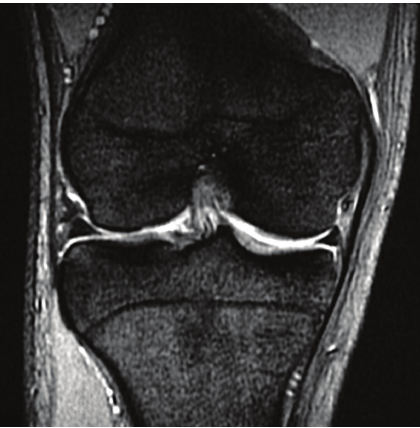
Figure 1: T2-weighted coronal magnetic resonance image of the right knee. Small triangular fragment located over the normal lateral meniscus.